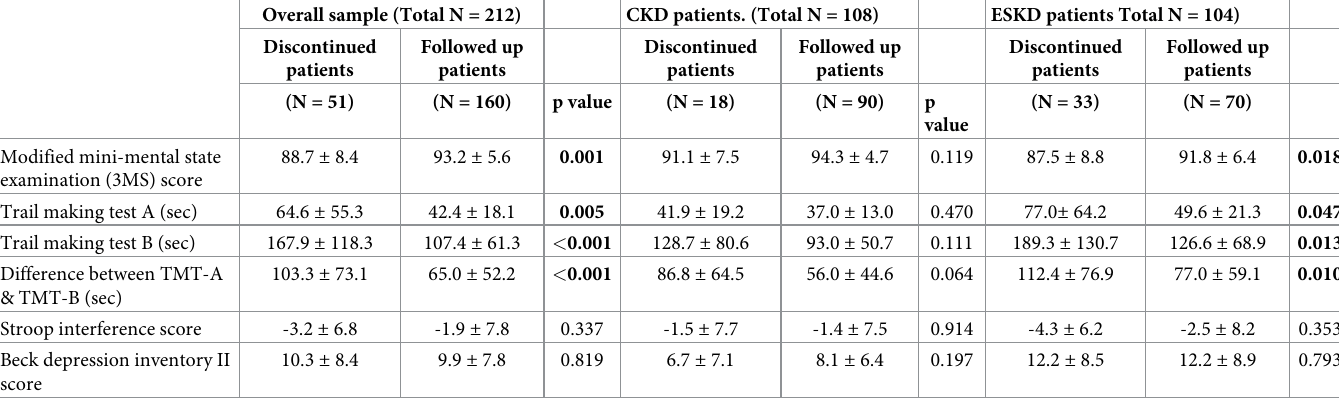
Table 3. Baseline markers of cognitive function and depression among patients who discontinued the study before follow-up assessment compared to patients who completed follow-up assessment, in the overall sample, CKD and ESKD